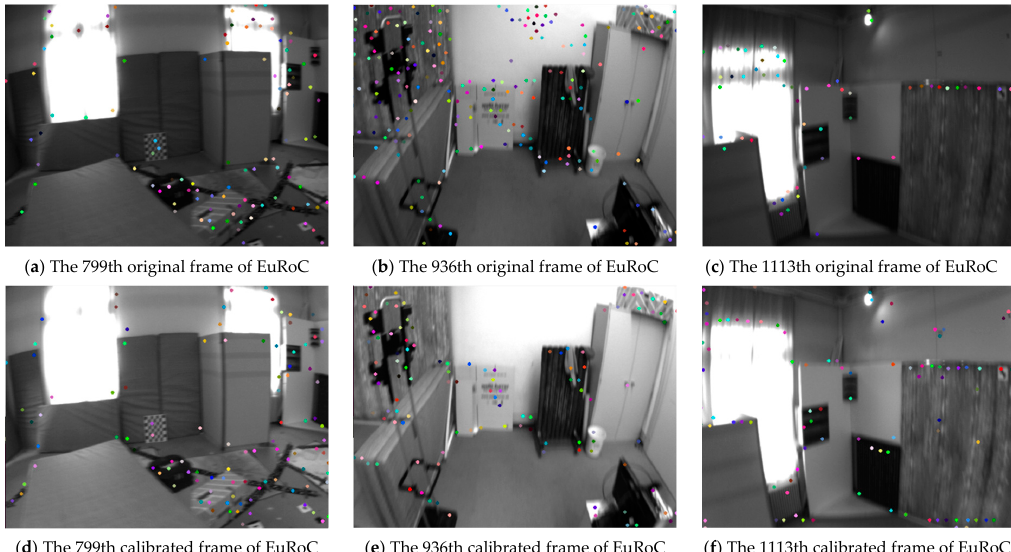
Figure 6. The experimental results on the EuRoC V1_03_difficult dataset. Subfigures ( d ), ( e ) and ( f ) are modified from subfigures ( a ), ( b ) and ( c ) respectively.